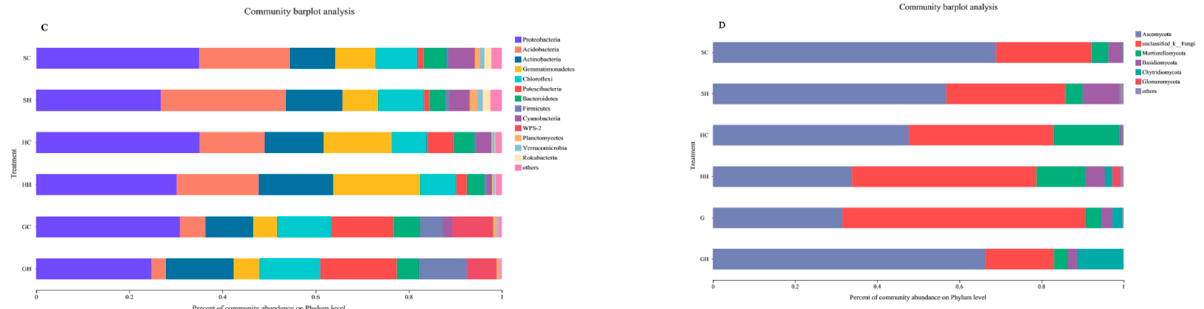
Figure 3. The shannon and chao indexes of the microbial community in soils with three different acidity levels ( A , B ); Predominant flora species in relative abundance at the microbial phylum level of three soil treatments. ( C , D ) represent bacteria and fungi, respectively. Capital letters in the figure indicate significant differences in bacterial communities among groups and lowercase letters indicate significant differences in fungal communities among groups ( p < 0.05).